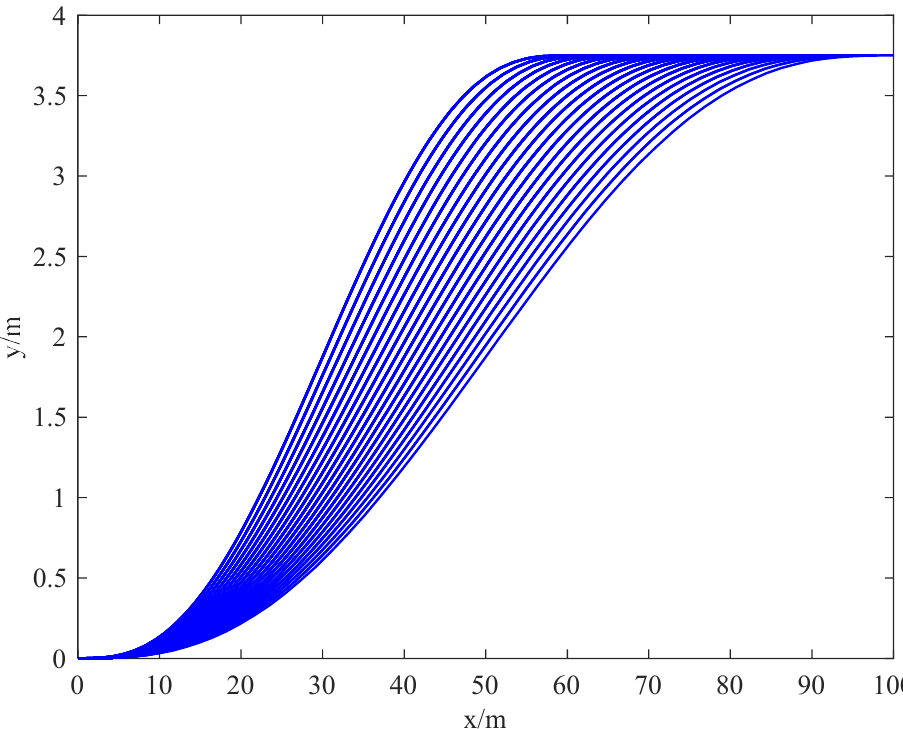
velocity of the ego vehicle is 50 km/h <= v e < = 60 km/h are added, the minimum lane 60km / h v   are added, the minimum lane e changing time is 1.171 s, collision avoidance meets the algorithm of Section 2.2, and the feasible lane changing trajectory cluster is finally obtained, as shown in Figure 5. The ego vehicle is relatively safe and comfortable to drive with these trajectories.